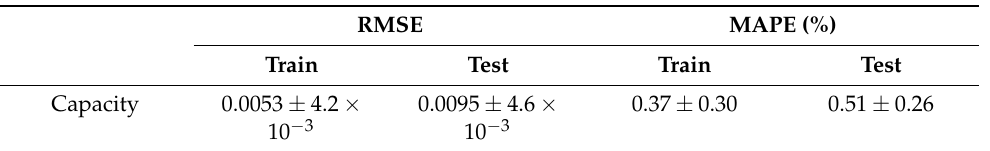
Table 3. Average performance of capacity model trained on batches 1–3 tested on batches 4–8, with 95% prediction